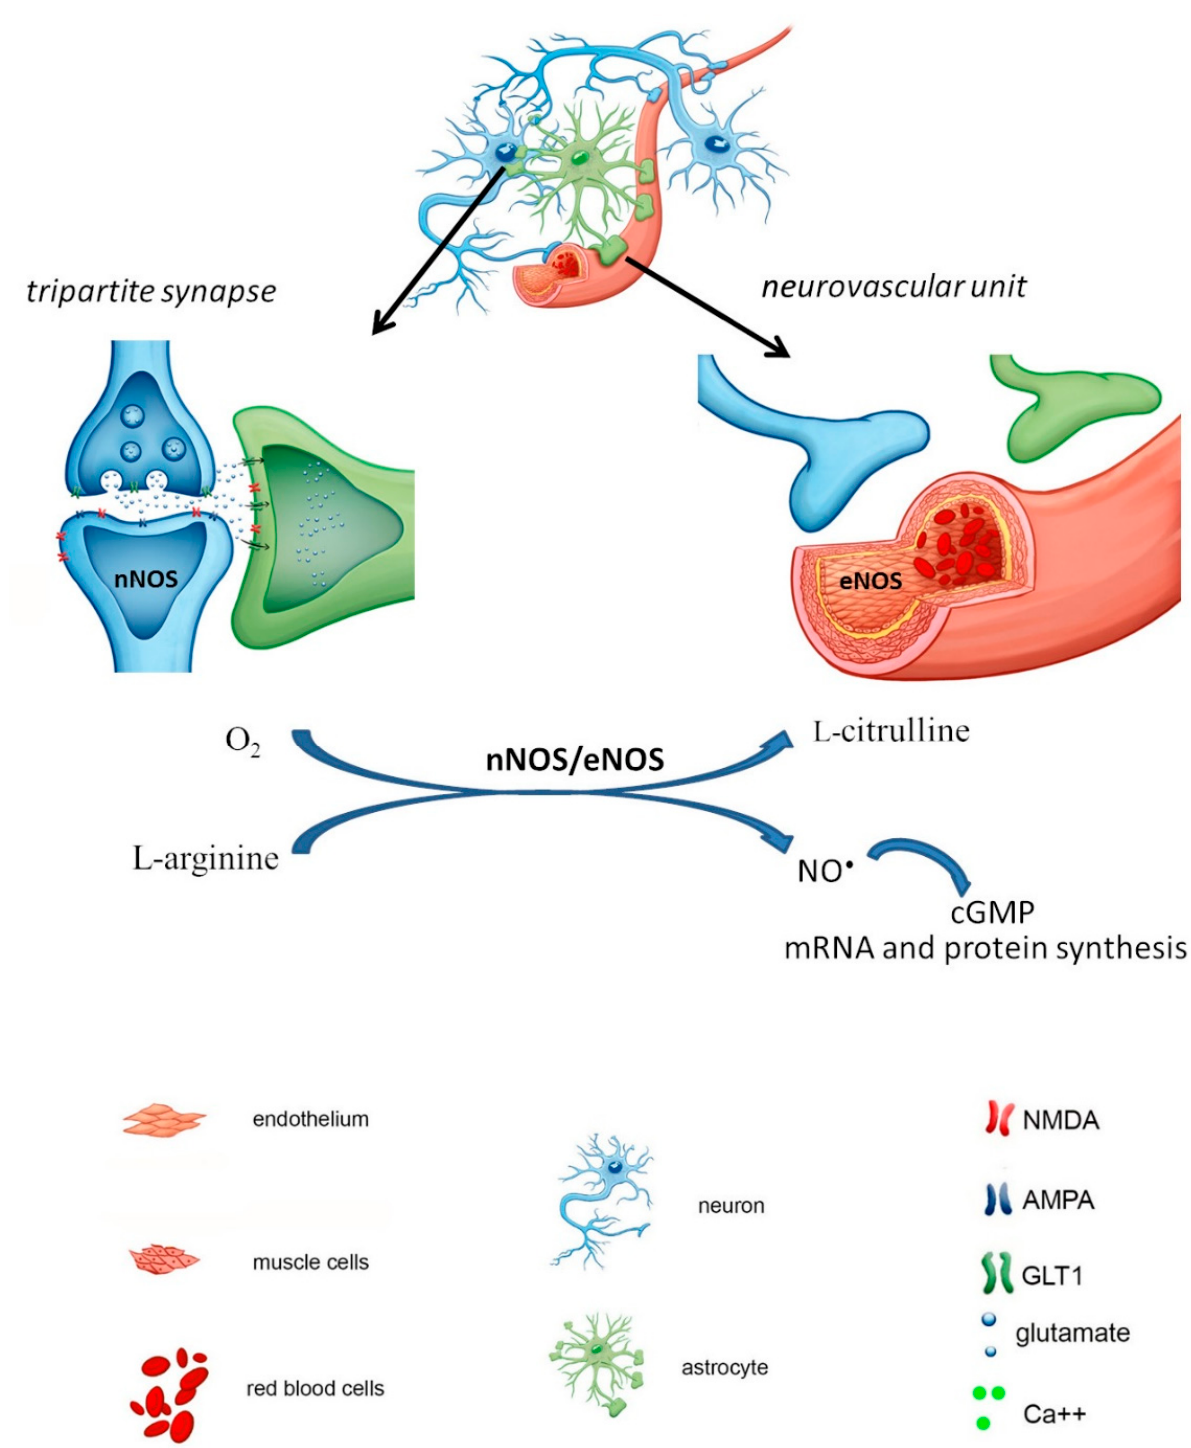
Figure 1. The activity of nNOS/eNOS dependent pathways in the brain under physiological conditions: glutamate released from the presynaptic neuron is rapidly uptaken by the astrocyte; nNOS and eNOS are kept at the normal level and both enzymes synthesize NO • which activates cGMP synthesis